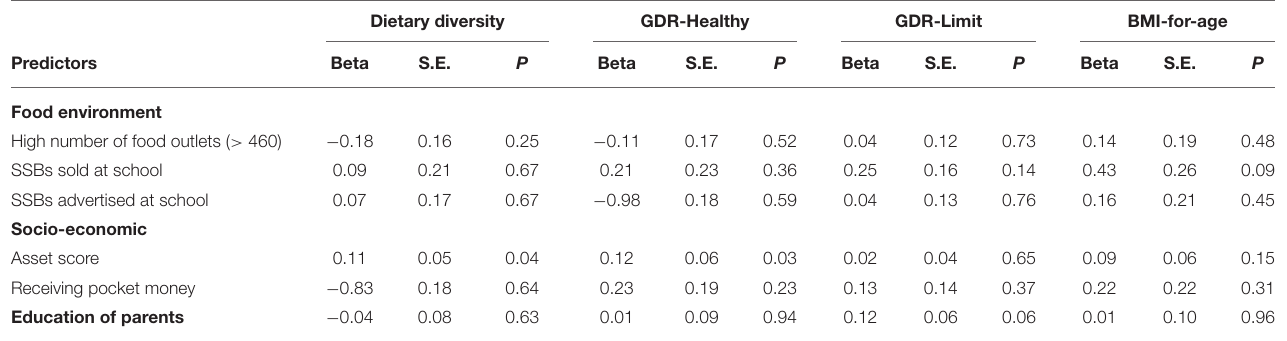
TABLE 5 | Potential influencing factors on dietary diversity, quality or nutritional status by applying multiple linear regression. Dietary